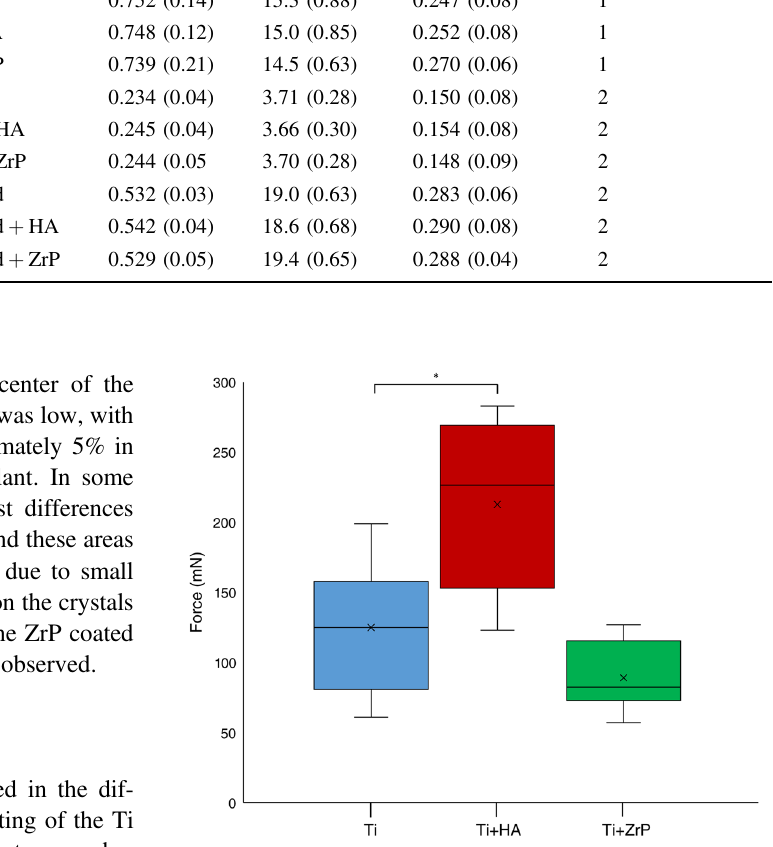
Table 2 Results of the interferometry analysis of the implants